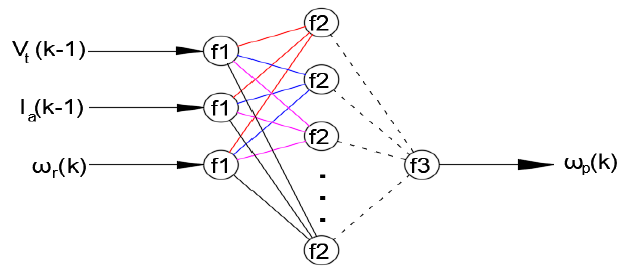
Figure 22. Basic ANN structure consisted of 3 layers [45].